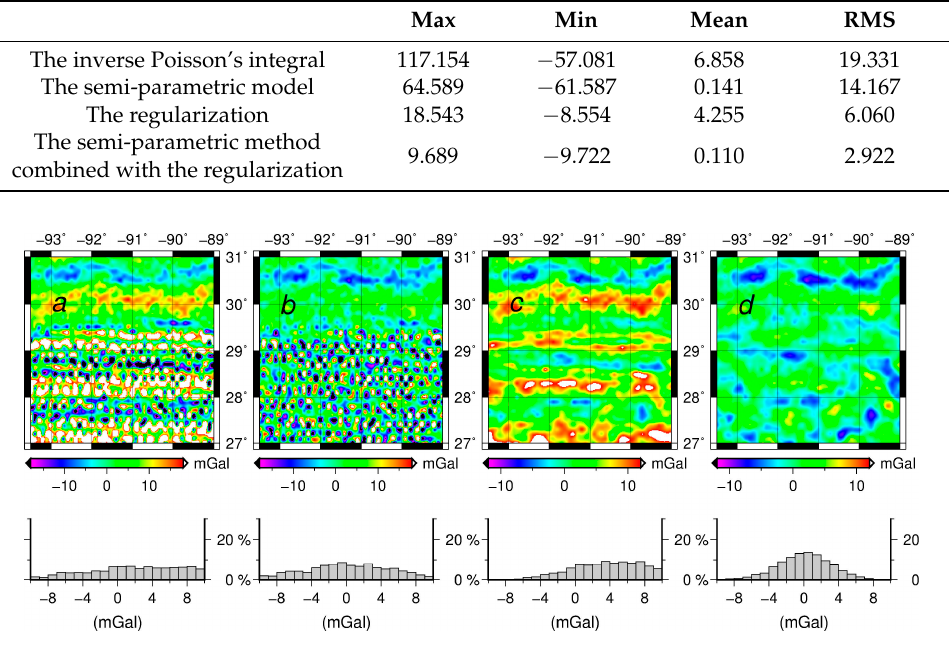
Figure 2. The distribution and the histograms of the differences between the downward continued values and the original values in the Louisiana Gravity Project ( a ) The inverse Poisson’s integral; ( b ) The semi-parametric method; ( c ) The regularization; ( d ) The semi-parametric method combined with the regularization.